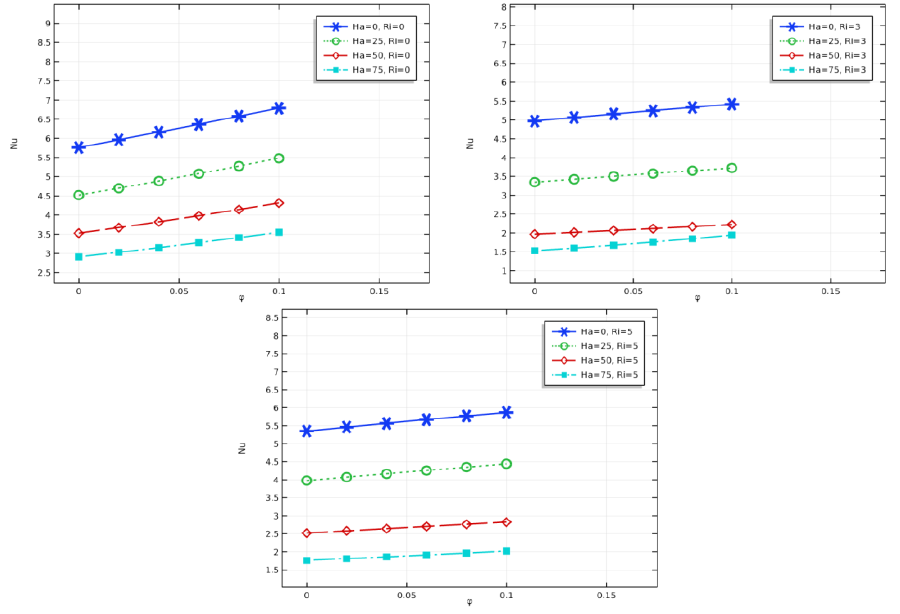
Fig. 9. Effect of Ha on average Nusselt Number for different Ha and Ri = 0, 3,